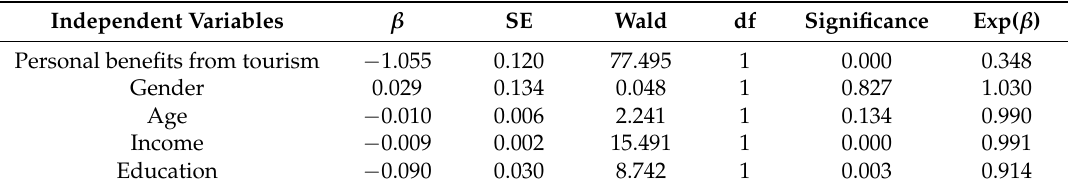
Table 3. Results of logistic regression analysis for respondents in the spatial clustering of negative tourism impacts.